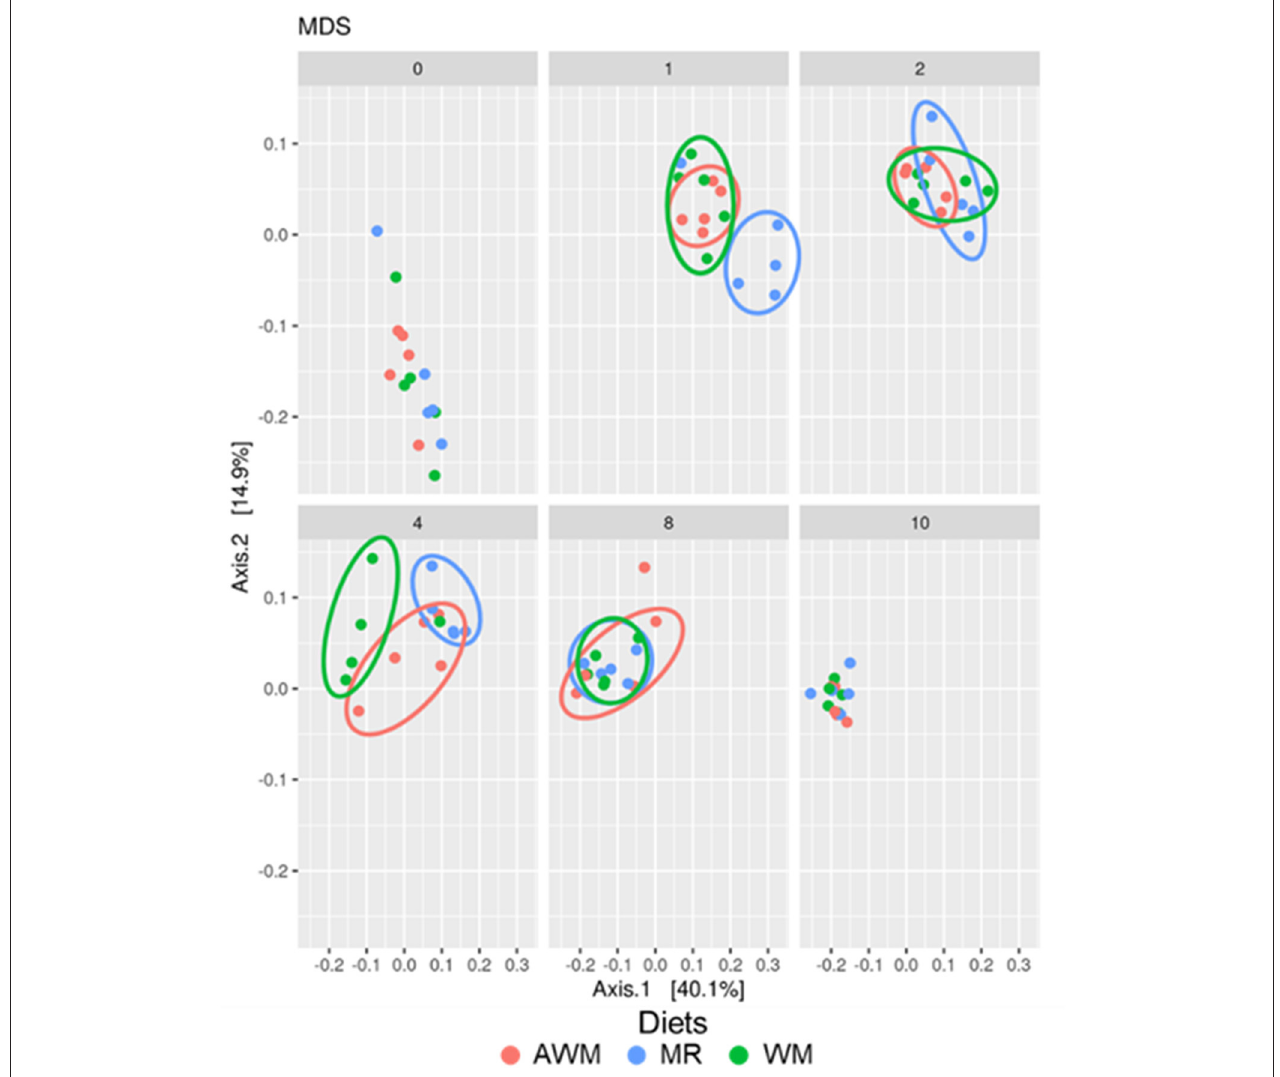
FIGURE 4 | Effect of the interaction of liquid diets with the different ages of the dairy calves on the structure of the microbial community in fecal samples in dairy calves fed different liquid diets. Multidimensional scaling (MDS) showing the weighted UniFrac distance metric. AWM, Acidified whole milk; MR, Milk Replacer; WM, Whole